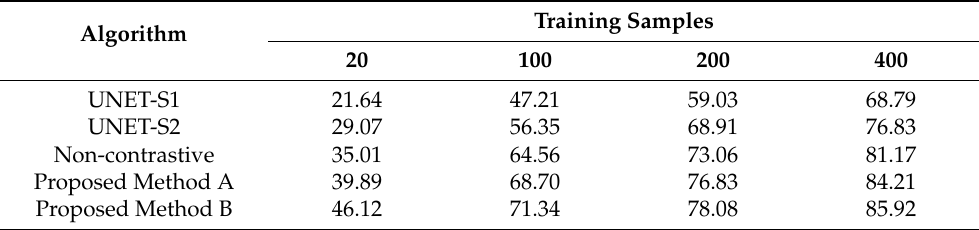
Table 5. F1-Score Comparison between the proposed method and baseline methods segmentation performance on the testing dataset using different amount of training